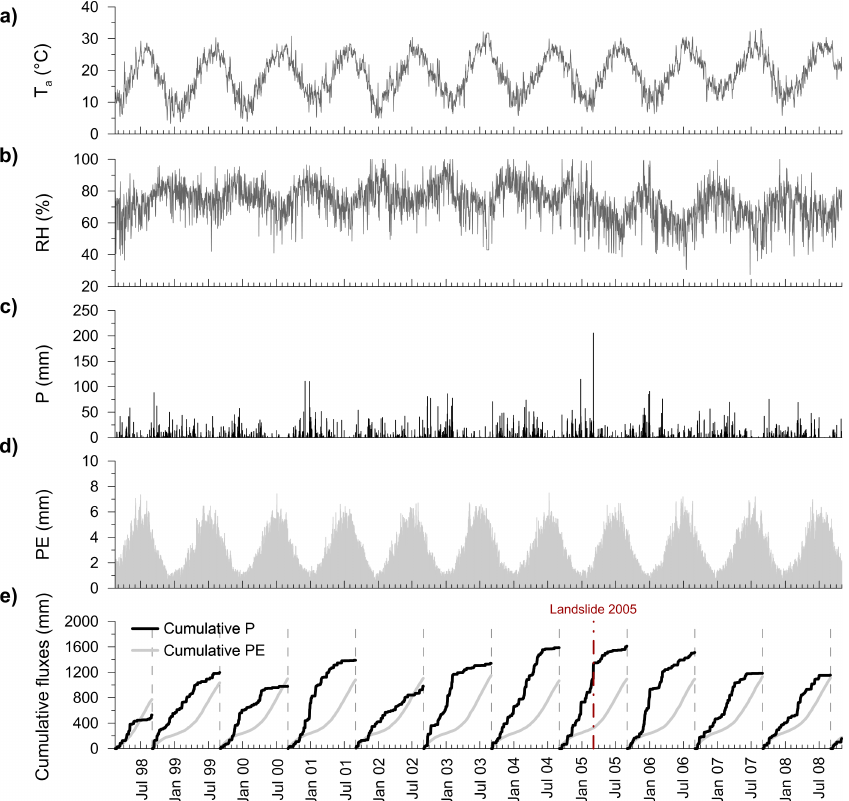
Figure 3. Meteorological variables recorded at the 2005NIL site between January 1998 and August 2008: (a) mean daily air temperature ( T a ); (b) mean daily air relative humidity (RH); (c) daily precipitations ( P ); (d) daily potential evaporation (PE); (e) precipitation ( P ) and potential evaporation (PE), cumulated during each hydrological